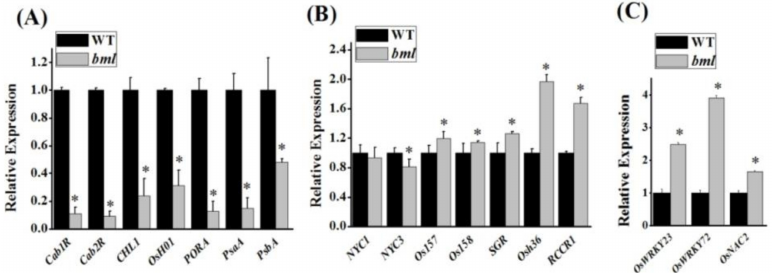
Figure 6. Expression of genes associated with leaf senescence in bml using quantitative reverse transcription polymerase chain reaction (qRT-PCR). Expression analysis of ( A ) photosynthesis-proassociated genes, ( B ) senescence-associated genes, and ( C ) senescence-associated transcription factors of bml mutants and WT rice plants at the heading stage. The expression levels are relative to rice Actin . All data are shown as means ± SD of five replicates; * p < 0.05 by Tukey’s